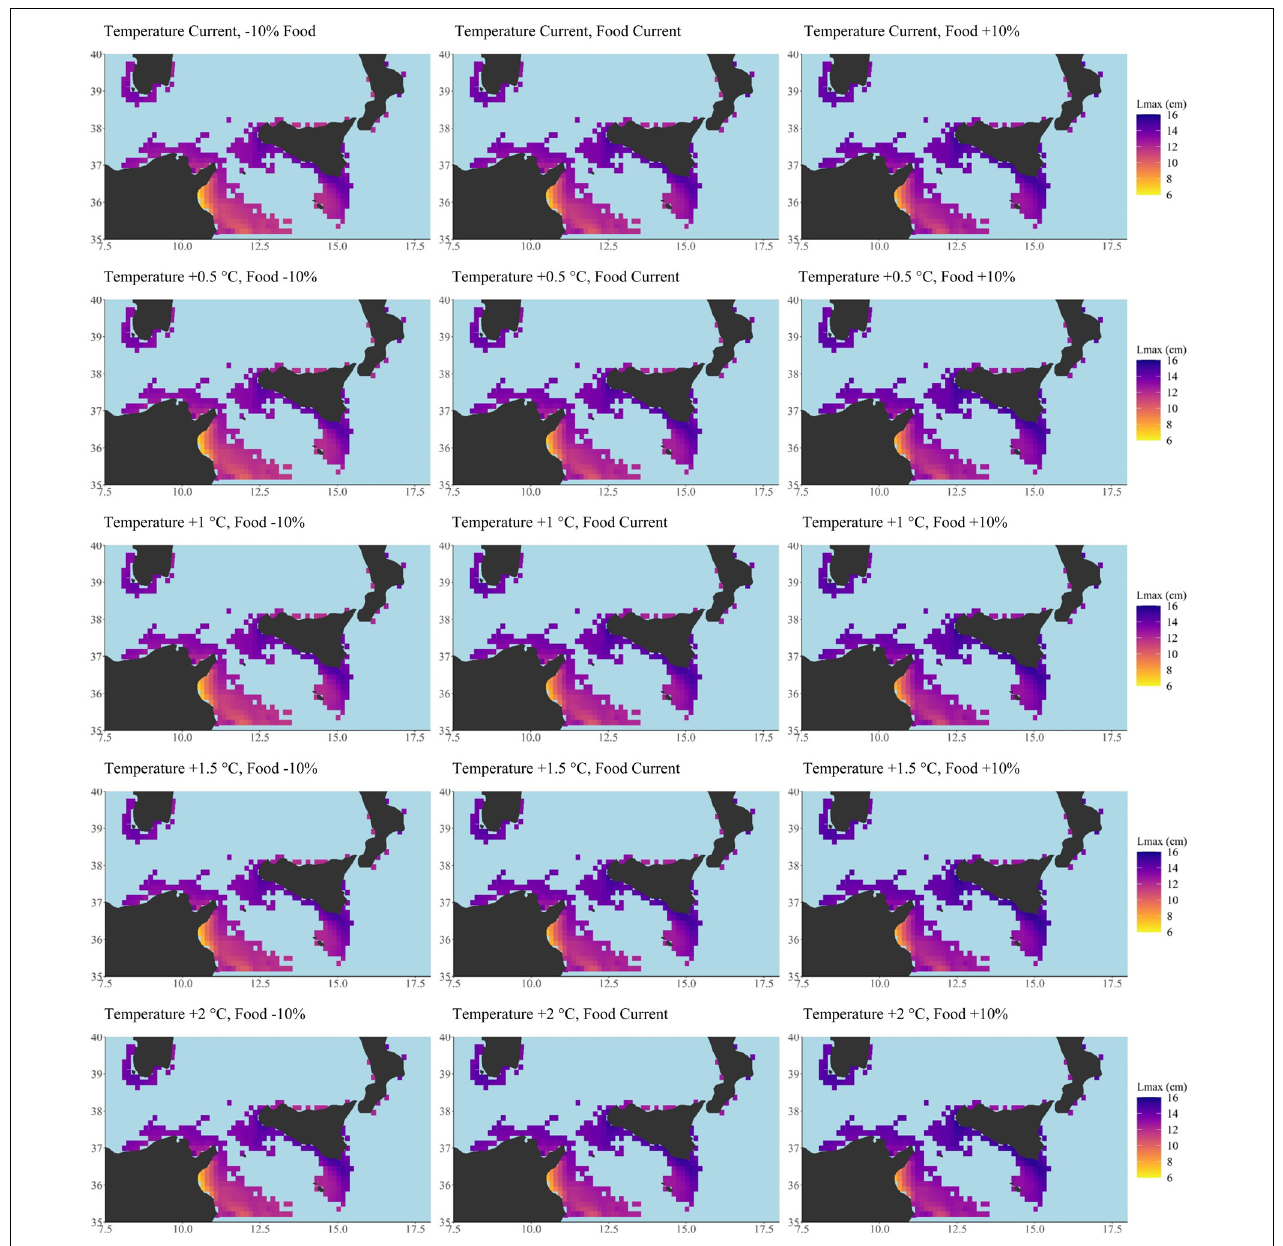
FIGURE 3 | Scenario-based quantitative maps of Maximum length (Lmax, cm) described by a continuous scale ranging (from 0 to 16) under current conditions of both temperature and food (central panel) and under four increasing temperature scenarios (+0.5; +1.0; +1.5; +2.0 ◦ C from top line to bottom line, central) coupled with decreasing (oligotrophic, -10% net primary production, left side) and increasing trophic conditions (eutrophic +10% net primary production, right side). Minimum, maximum, mean and median values for each scenario have been also reported as well as the global G statistic values at Supplementary Table S3 . Total number of cells = 346, cell resolution of 12.5 × 12.5 km 2 . Maps were created using R software (ggplot2 package).